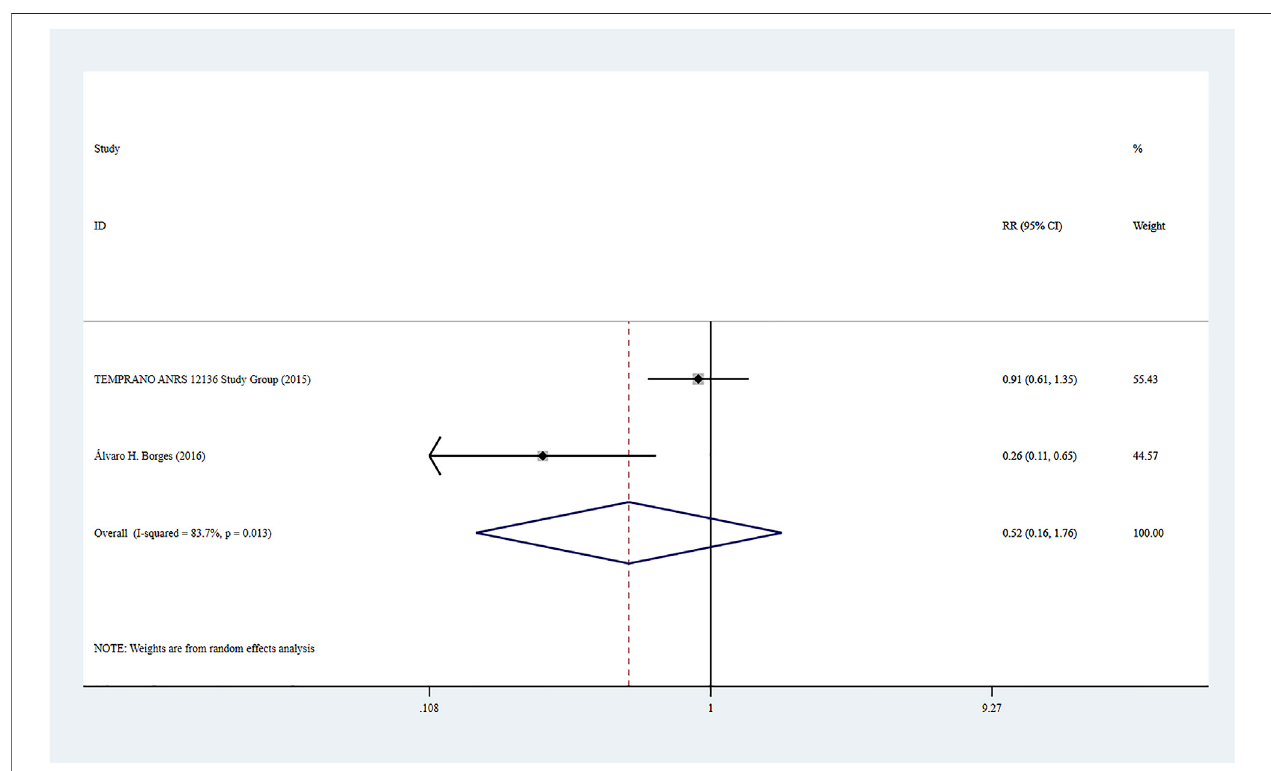
FIGURE 6 | Forest plot for Meta-analysis of adverse